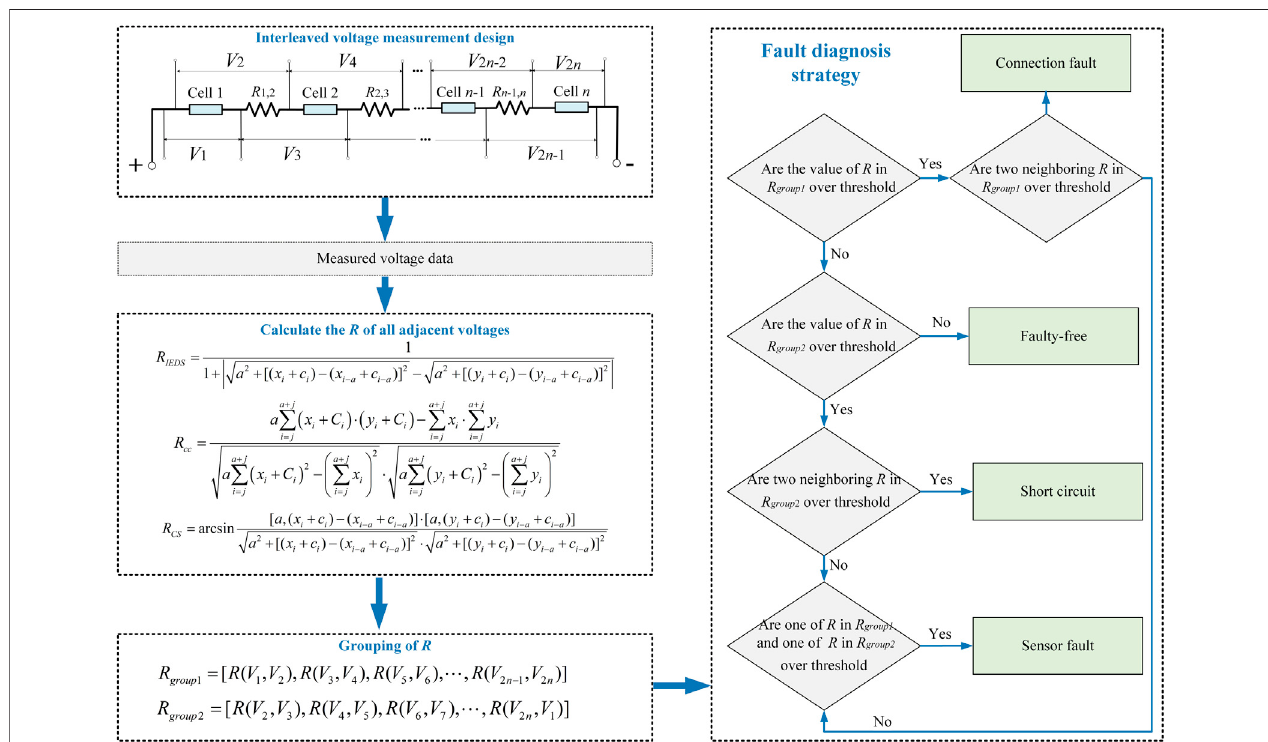
FIGURE 2 | Flow chart of fault